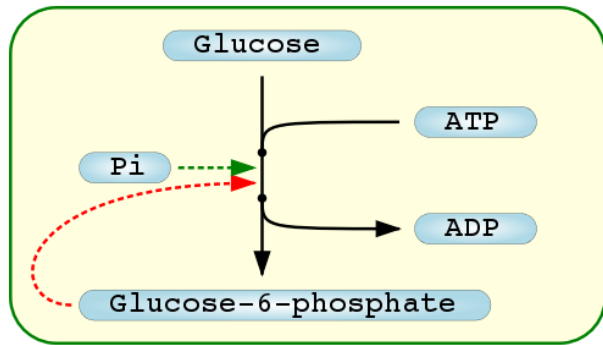
Figure 16: Another possible rendering of the example